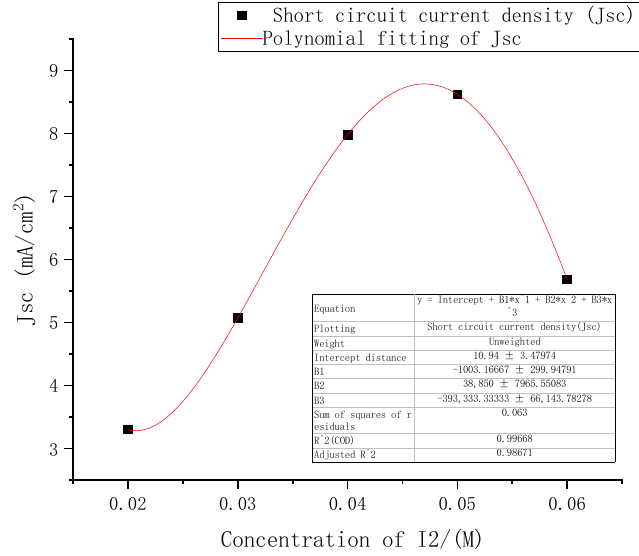
Figure 8. Fitting curve of short circuit current density at different electrolyte concentrations.